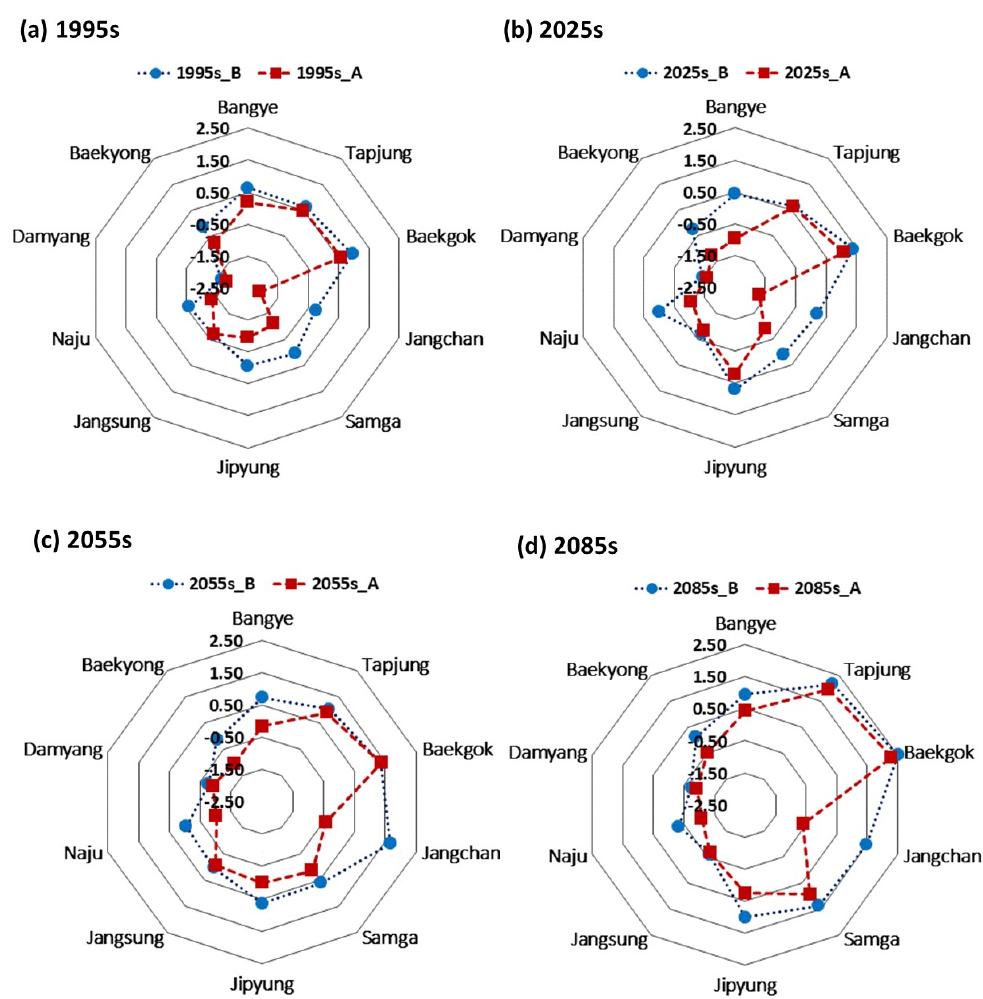
Figure 7. Calculation results of flood vulnerability indices for ten reservoirs after dam heightening under climate change. A stands for after dam heightening